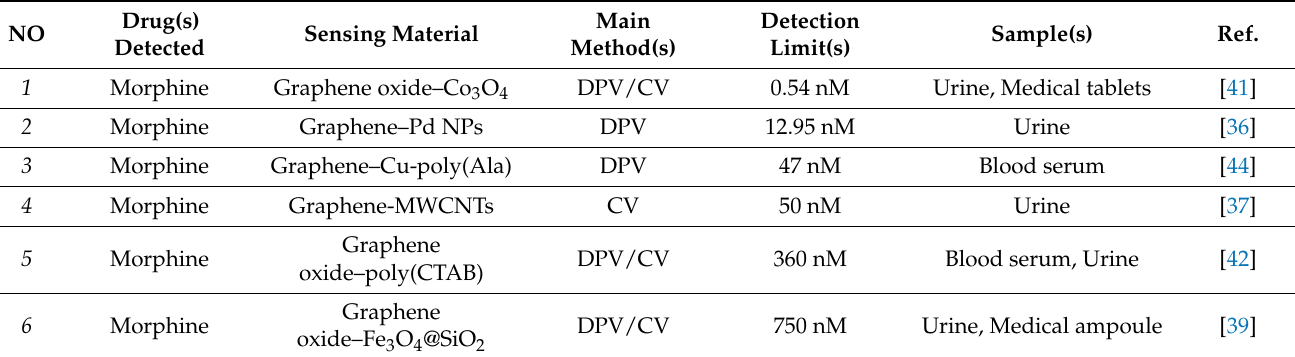
Table 1. Comparison of functionalizations, method of measurement and LoD of graphene-based electrochemical sensors for the determination of drugs in various